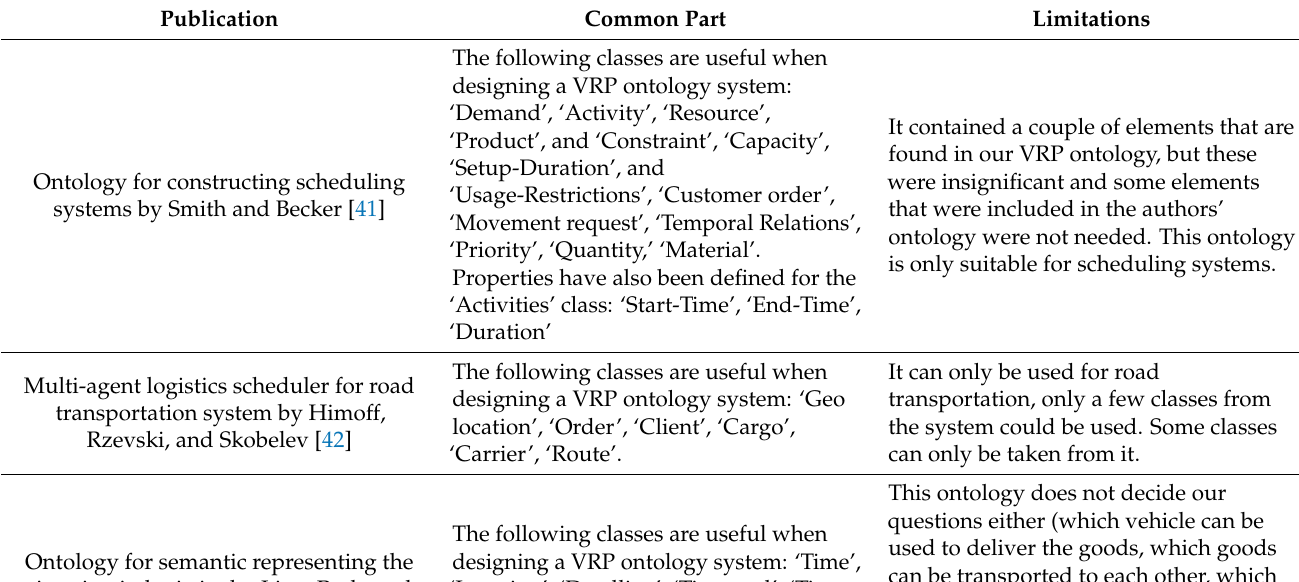
Table 1. The parts and building blocks that can be used for a part of our